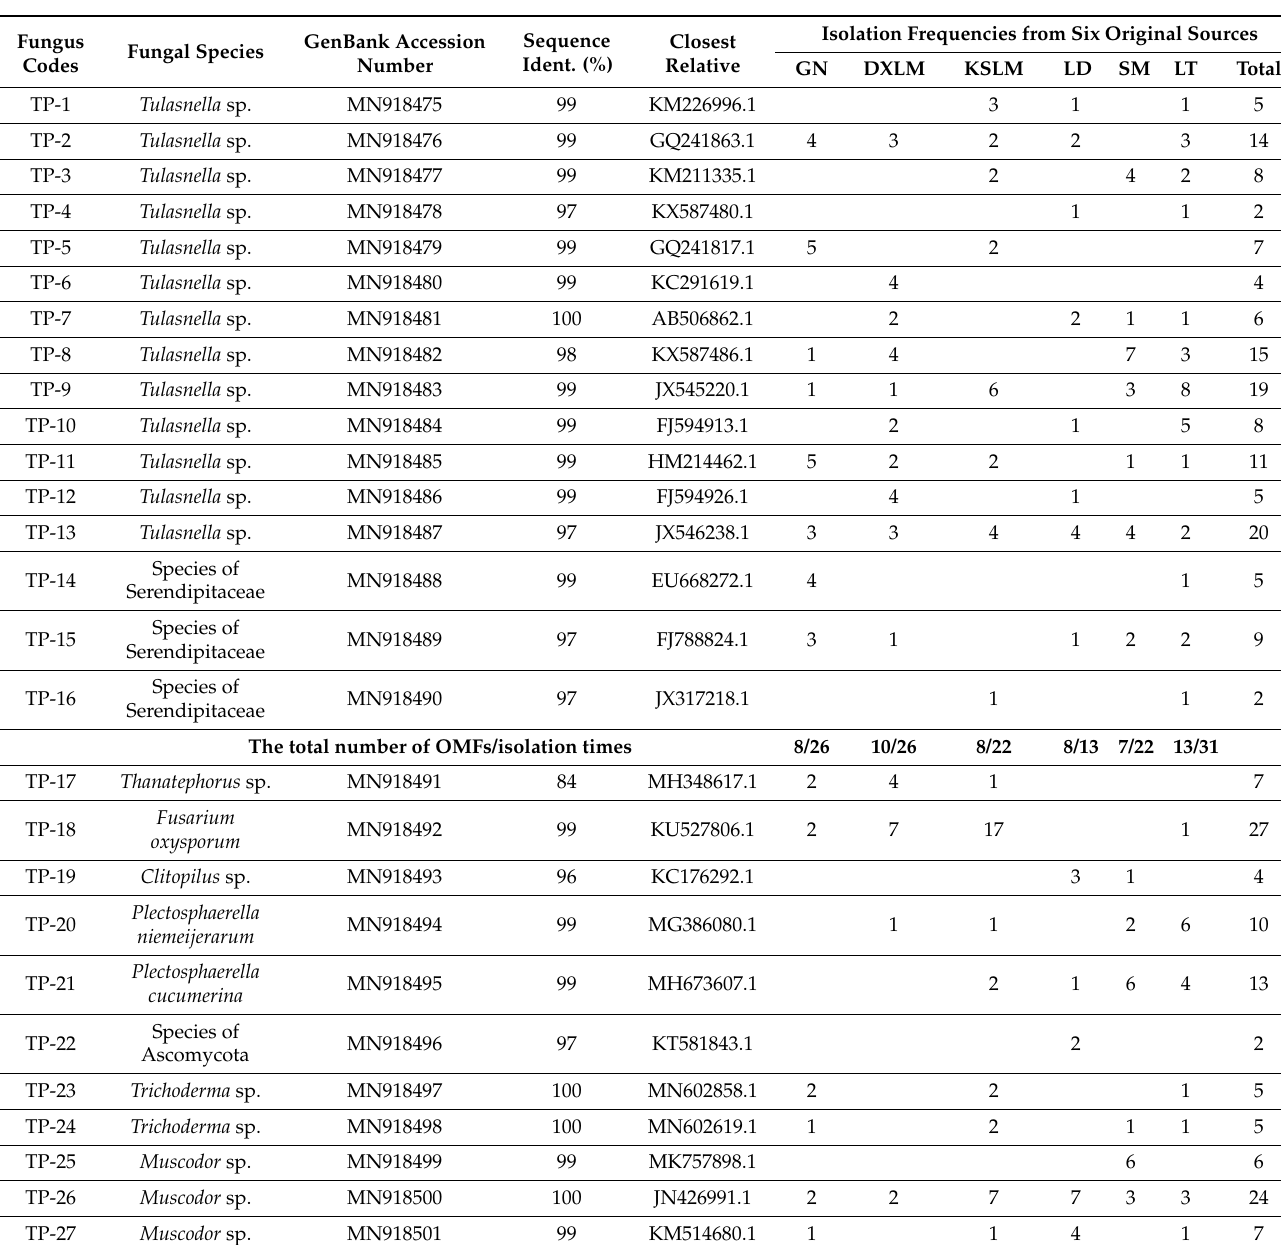
Table 2. The fungi obtained via ex situ seedling baiting experiments in Dendrobium officinale , including 16 orchid mycorrhizal fungi (OMFs; TP1-TP16) and 11 non-OMFs (TP17-TP27) with their isolation frequencies from six original